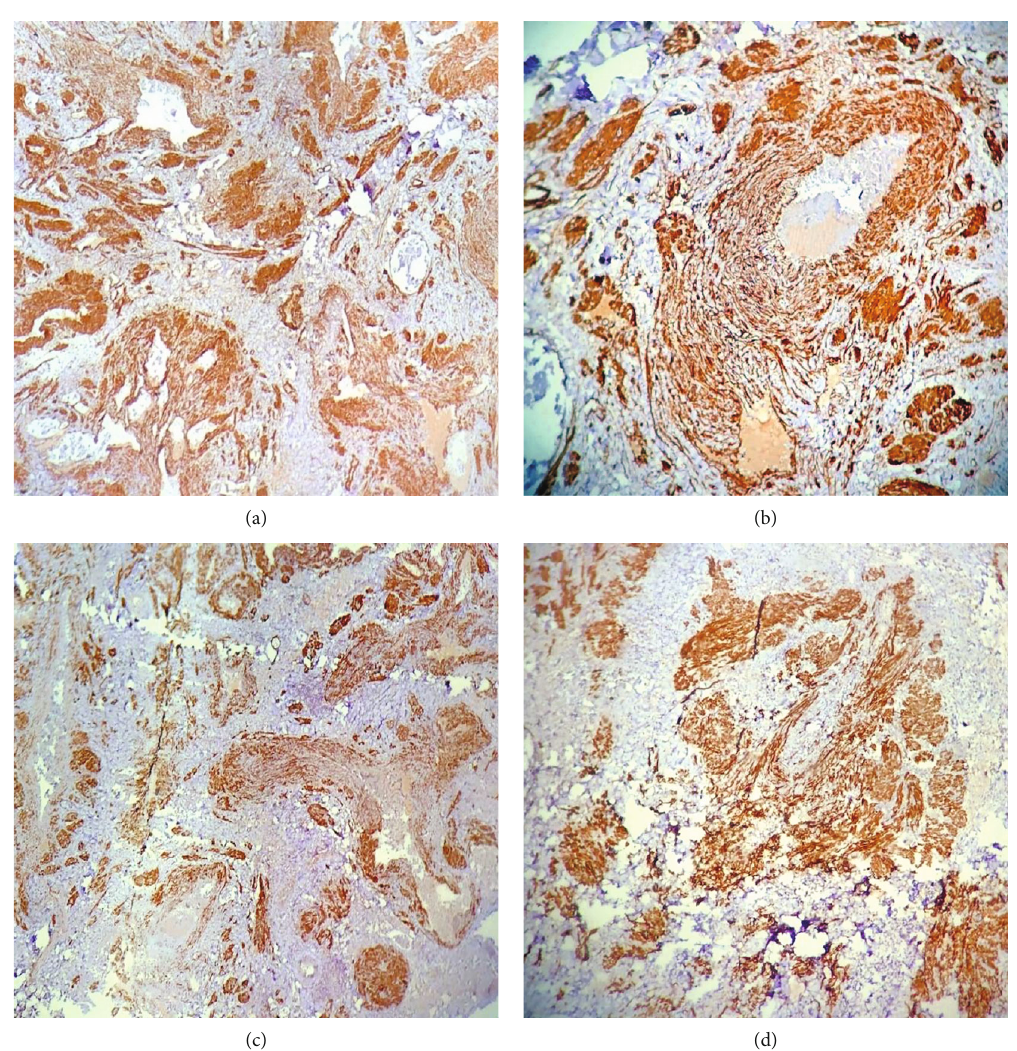
Figure 7: (a) × 40 and (b) × 100 positive IHC staining for SMA. (c) × 40 and (d) × 100 positive for